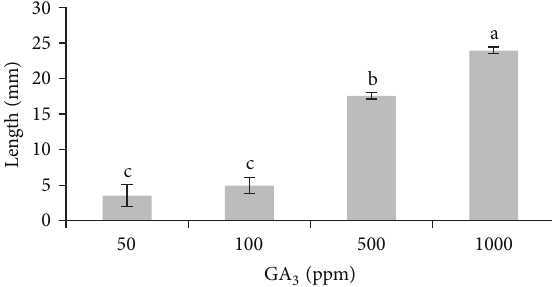
Figure 6: Stem length of Gentiana lutea var. aurantiaca seedlings using different GA 3 doses (50, 100, 500, and 1000 ppm) on the 90th day after sowing. Bars with different letters are significantly different ( 𝑃 = 0.05 ) according to